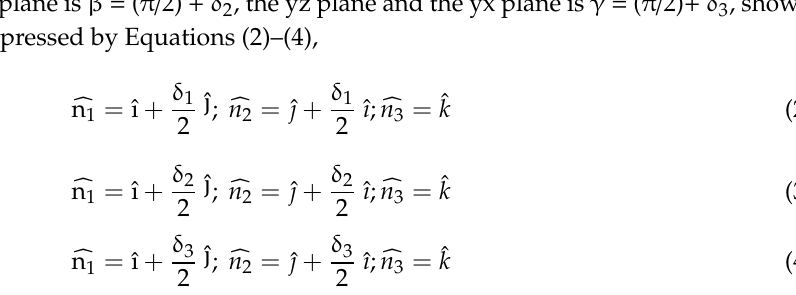
Figure 3. ( a ) Normal to the reflecting faces with dihedral-angle offsets; ( b ) angle between each plane: α = ( π /2)+ δ 1, ; β = ( π /2)+ δ 2 ; γ = ( π /2)+ δ 3 ; and ( c ) direction of symmetry axis. It is desirable to have the unit normals given in the coordinate system of the symmetry axis of the corner cube since the incidence angle of the laser beam is given with respect to this axis. The symmetry axis is in the direction of the vector x = y = z = 1, as shown in Figure 3c; we see that cos θ (cid:3002) = (cid:2869) √(cid:2870) ; sin θ (cid:3002) = (cid:2869) √(cid:2870) ; cos λ (cid:3002) = √(cid:2870) √(cid:2871) ; sin λ (cid:3002) = (cid:2869) √(cid:2871) . The normals in the xyz coordinate system can be given in the coordinate system of the symmetry axis by rotating the original coordinate system about the z axis by θ A and about the y axis by −λ A . This brings the x axis along the axis of the matrix form, and the total rotation is given